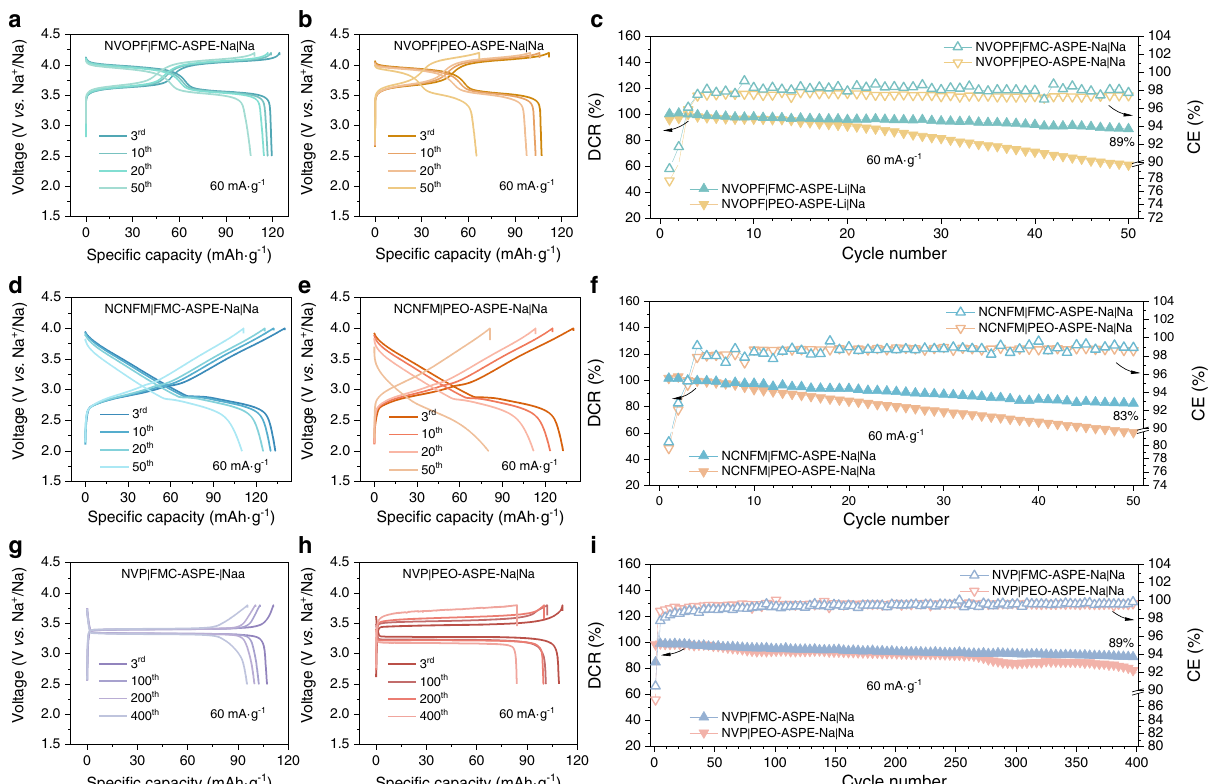
Fig. 7 Na-ion storage performance of the all-solid-state sodium metal batteries with different cathodes and all-solid-state polymer electrolytes (CR2032 coin cell, 80 °C). a , b Comparison of the charge/discharge voltage pro fi les of a Na 3 (VOPO 4 ) 2 F (NVOPF)|PEO-ASPE-Na|Na and b NVOPF|FMC- ASPE-Na|Na full cells. c Comparison of DCR and CE of NVOPF|PEO-ASPE-Na|Na and NVOPF|FMC-ASPE-Na|Na full cells; d , e Comparison of the charge/ discharge voltage pro fi les of d NaCu 1/9 Ni 2/9 Fe 1/3 Mn 1/3 O 2 (NCNFM)|PEO-ASPE-Na|Na and e NCNFM|FMC-ASPE-Na|Na full cells. f Comparison of DCR and CE of NCNFM|PEO-ASPE-Na|Na and NCNFM|FMC-ASPE-Na|Na full cells. g , h Comparison of the charge/discharge voltage pro fi les of g Na 3 V 2 (PO 4 ) 3 (NVP)|PEO-ASPE-Na|Na and h NVP|FMC-ASPE-Na|Na full cells. i Comparison of DCR and CE of NVP|PEO-ASPE-Na|Na and NVP|FMC-ASPE-Na|Na